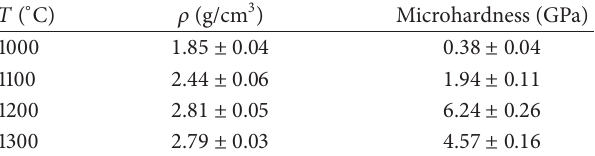
Figure 1: X-ray diffractograms of the BCP samples sintered at different temperatures. Table 1: Mean values (with standard deviations) of density and Vickers microhardness of the BCP ceramics sintered at different